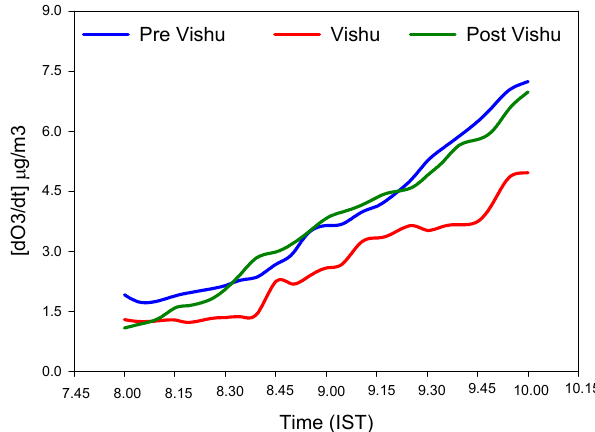
Figure 9. A magnified view of the rate of increase of ozone in early morning.